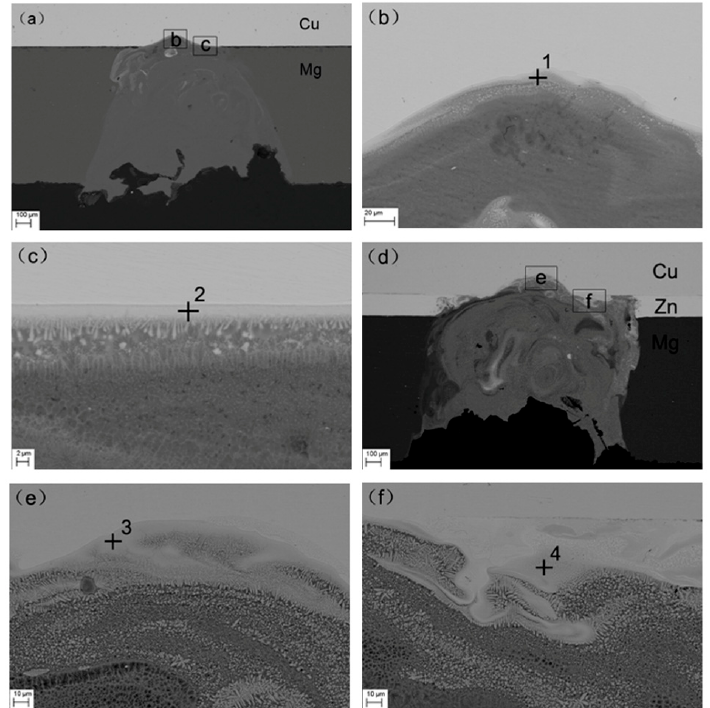
Figure 3. Areas in the welded joint analyzed by EDX: ( a ) Directly welded joint; ( b ) Point 1; ( c ) Point 2; ( d ) Welded joint with a 0.1 mm thick Zn interlayer; ( e ) Point 3; ( f ) Point 4.